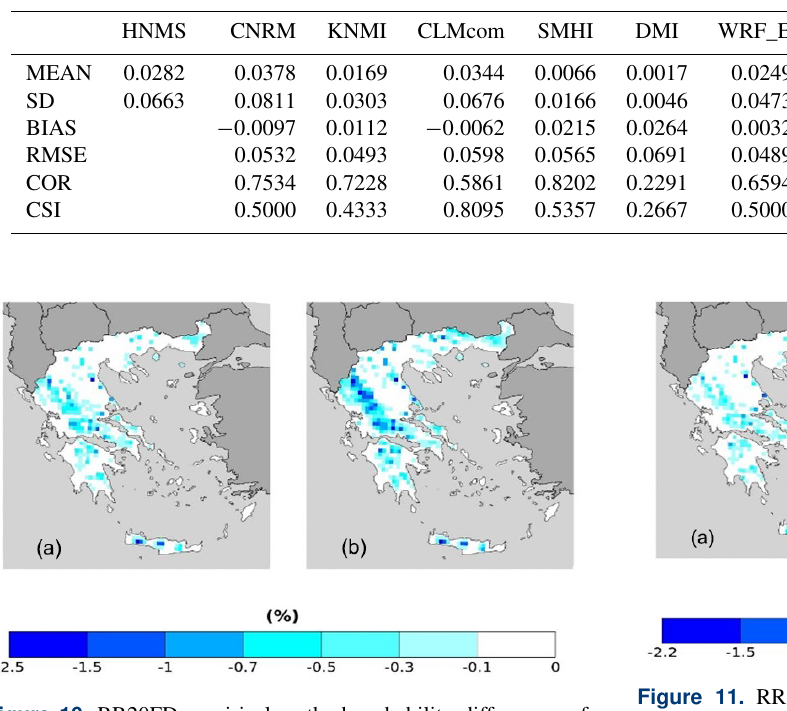
Figure 10. RR20FD empirical method probability differences of future–past periods for (a) RCP4.5 and (b) RCP8.5 scenarios.